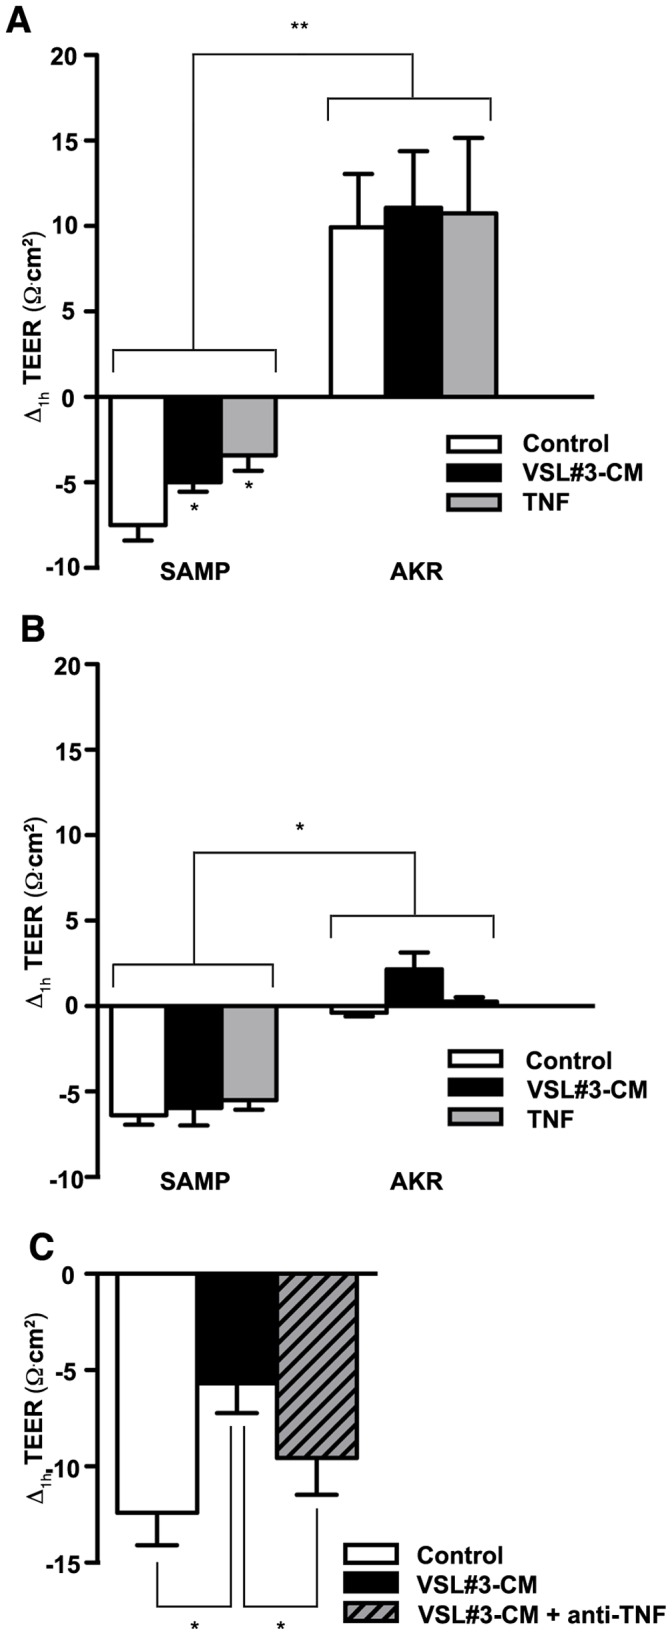
VSL#3 decreases epithelial paracellular permeability in a TNF-dependent manner on ilea from pre-inflamed SAMP mice.Epithelial paracellular permeability was assessed by measuring TEER on ex vivo cultured full-thickness ilea from (A), 3- to 4-wk old SAMP, prior to the onset of inflammation, (B), older (>20 wks) SAMP with established ileitis, and age-matched AKR controls at T0 and after 1 h (ΔTEER) exposure to VSL#3-CM or TNF (N = 6/exp grp). **p<0.01 vs. age- and treatment-matched AKR, *p<0.05 vs. vehicle cont. (C), Addition of a neutralizing antibody against TNF abrogated the positive effects of VSL#3 on ΔTEER in pre-inflamed ilea from young SAMP (N = 7 exp grp). *p<0.05 vs. vehicle cont. Results are combined from two independent experiments and expressed as mean ± SEM.